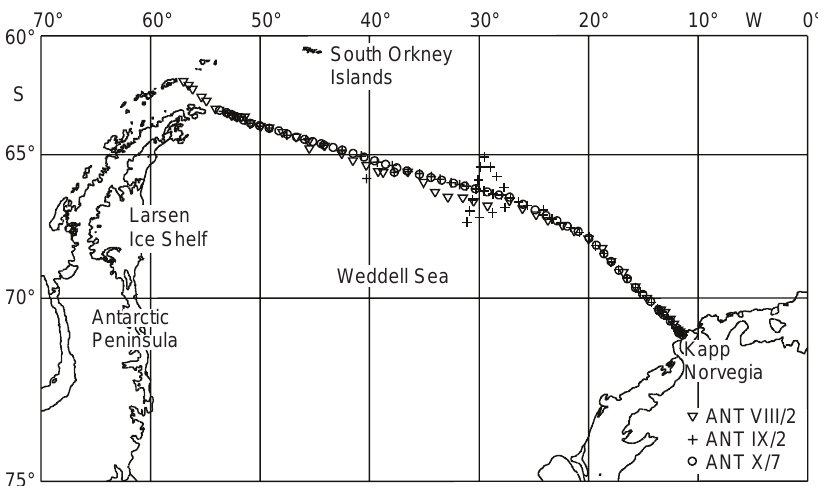
Fig. 1. CTD/rosette stations on the section across the Weddell Sea sampled during the three surveys in 1989 ( triangles ), 1990 ( crosses ) and 1992 (